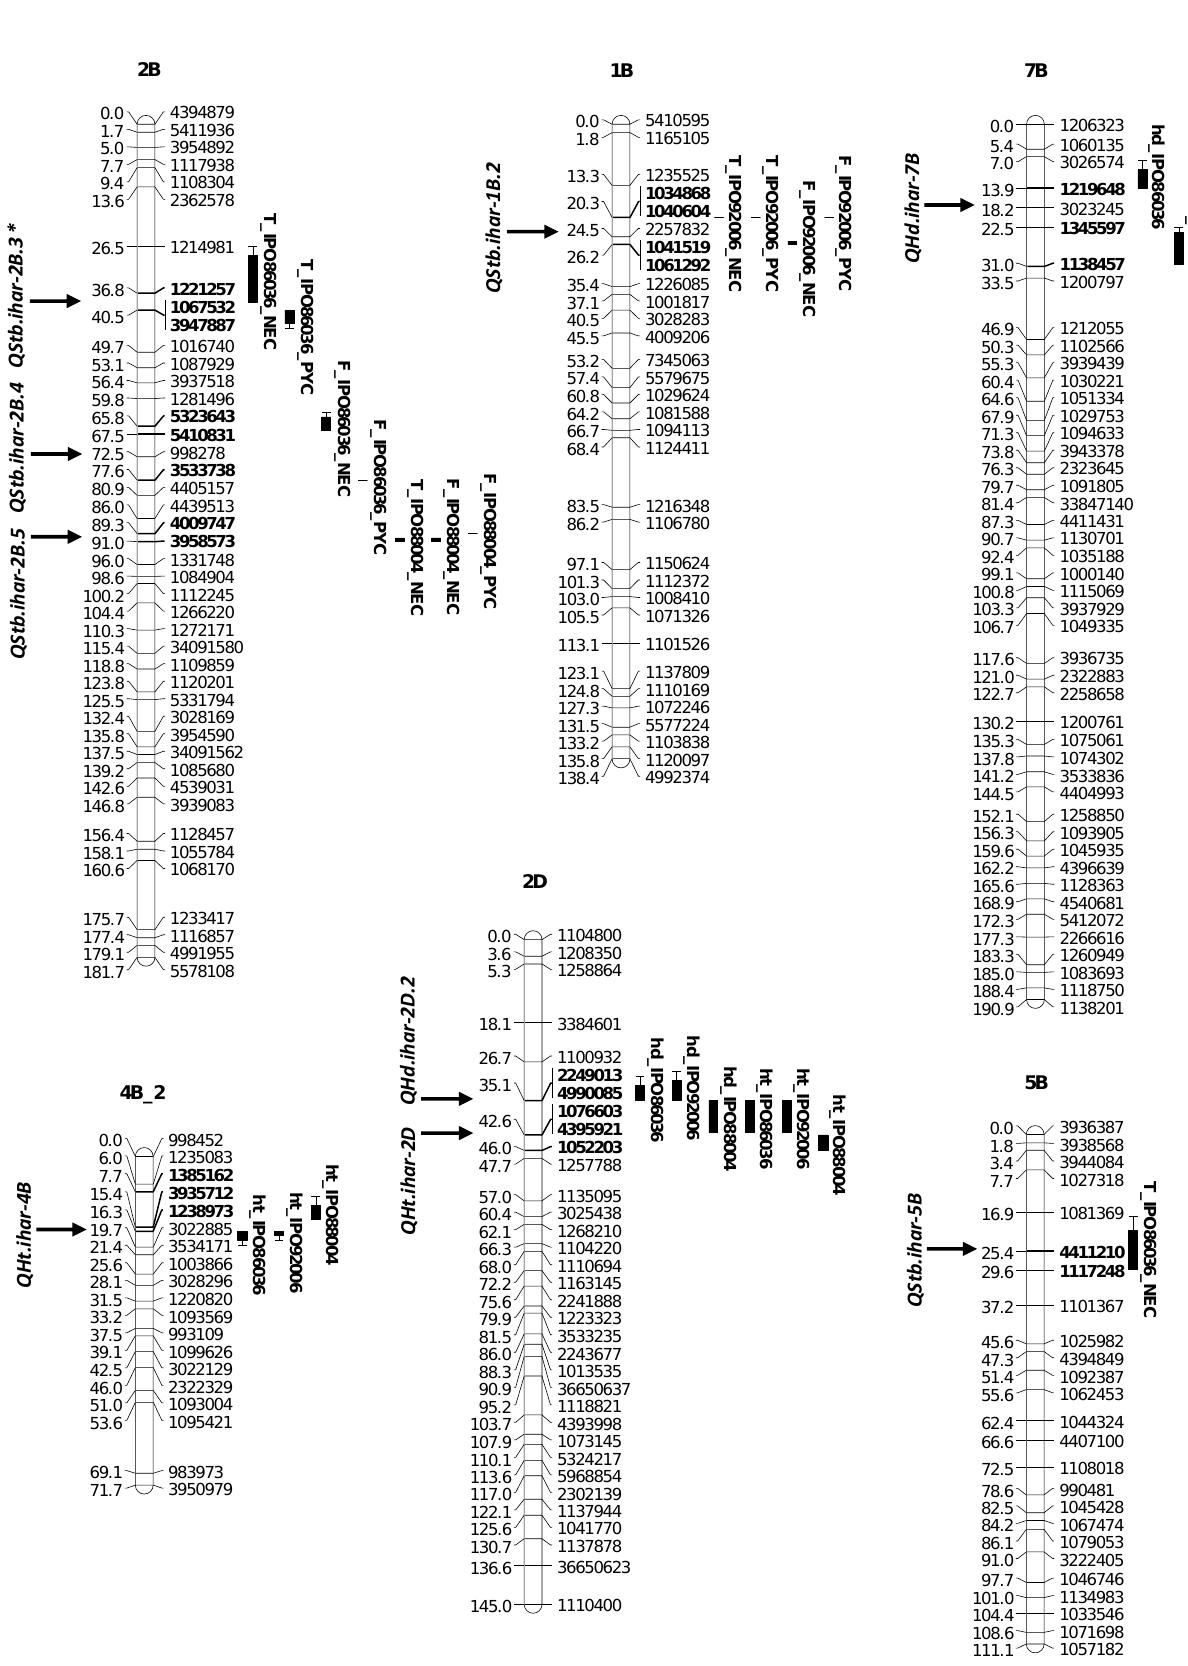
Figure 2. Location of QTL for resistance to STB in seedlings and adult plants and for plant height and for heading date in